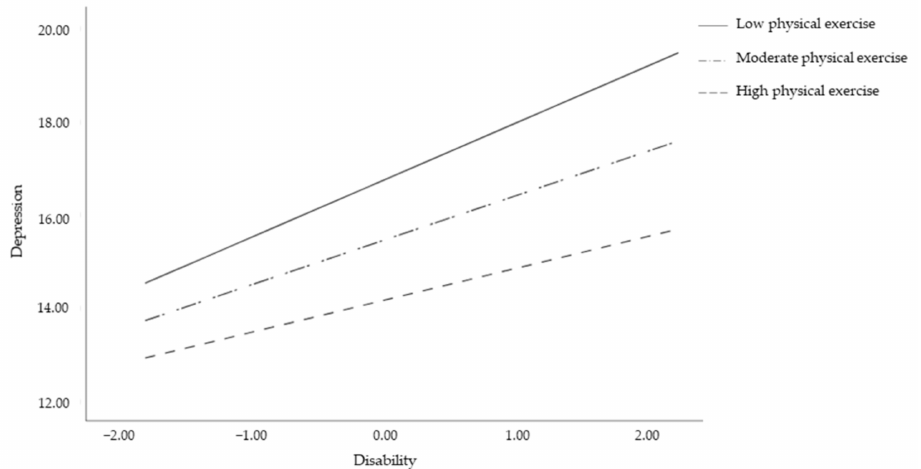
Figure 2. Interaction effect of disability by physical exercise on